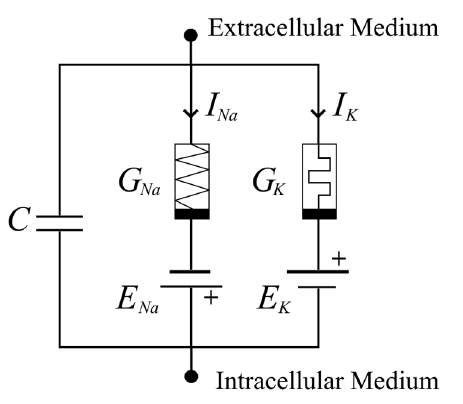
Figure 1. A compact equivalent circuit for the simplified Hodgkin–Huxley (HH) model .